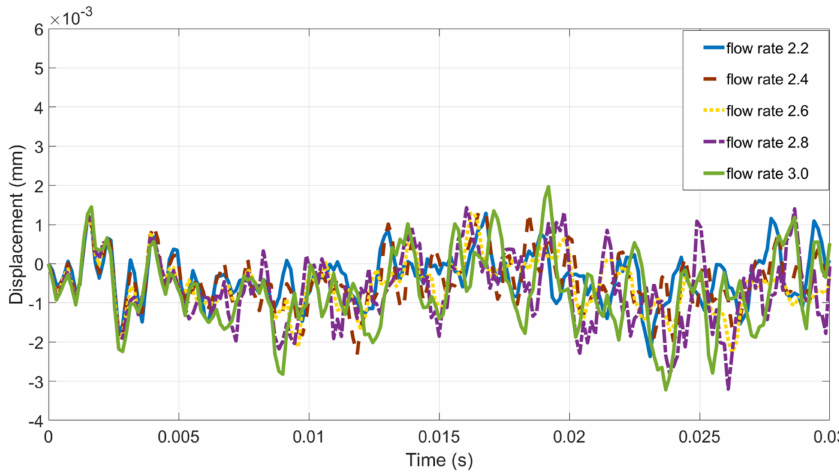
Figure 7. Displacement changing graph of sensor characteristic point C in the Z direction under the impacts of different momentum